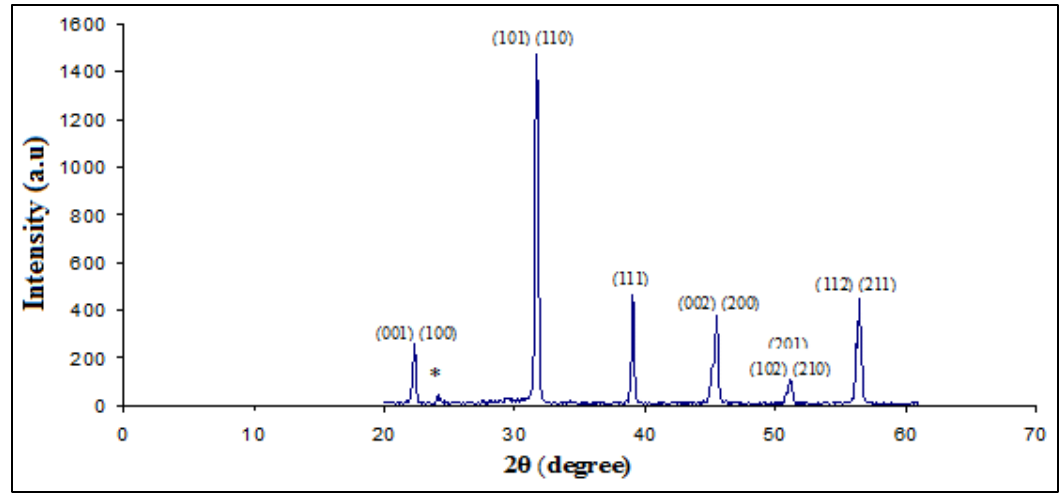
Figure 6: Barium Titanate XRD pattern at 900 ◦ C. In Figure (6) XRD pattern confirmed the existence of the Barium Titanate with tetragonal phase (the pattern matched with the standard pattern JCPDS No. 05-0626). In Figure (7) at 1000 ◦ C temperature there was a low intensity of Titanium Dioxide (TiO 2 ) but there was no Barium Carbonate.